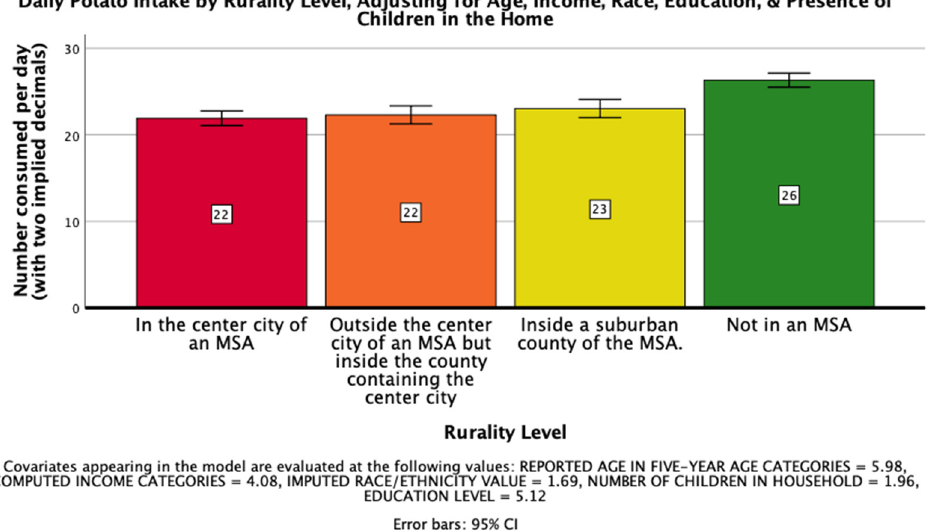
Figure 5. National Mean Daily Potato Intake.